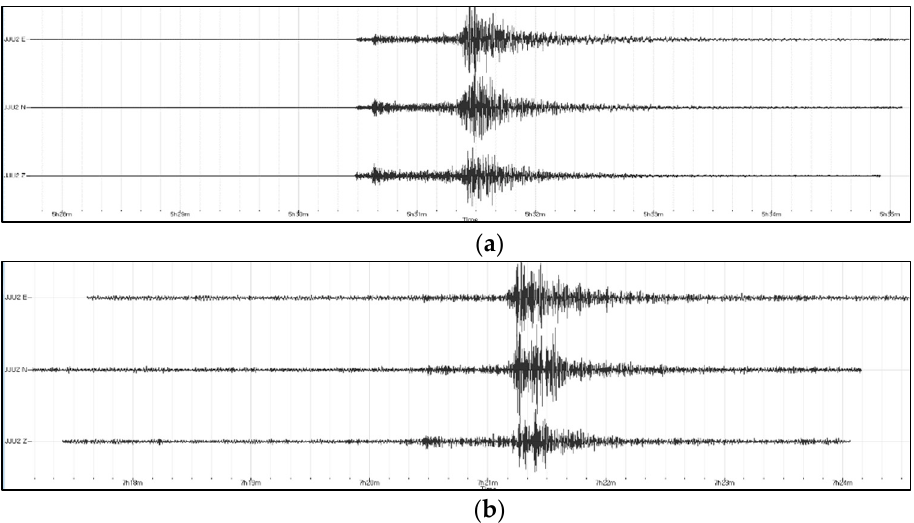
Figure 3. Three-component time history waveforms (EW, NS, UD) of the main earthquake (M, 5.4) and aftershock (M, 3.5) among the Pohang earthquake series at JJU2 station are shown in ( a ) and ( b ), respectively. ( a , b ),